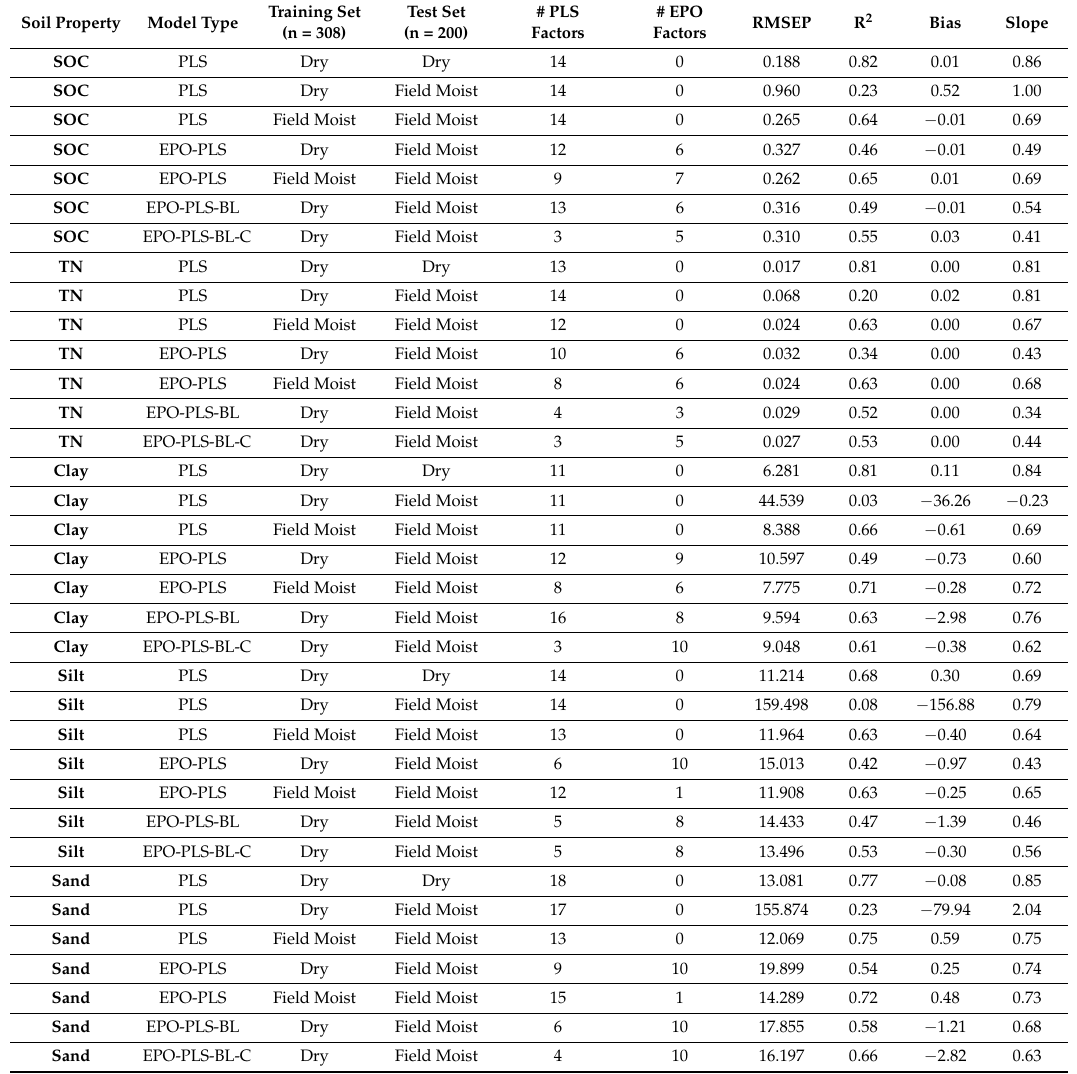
Table 3. The root mean square error of prediction (RMSEP) for the best model within each model type including partial least squares (PLS), external parameter orthogonalization (EPO) transformation, Bayesian Lasso (BL), and covariate addition (C) for each soil property: soil organic carbon (SOC), total nitrogen (TN), and particle size fractions in % (g × 100 g − 1 soil). The EPO transformation was determined on an independent set of field moist and dry spectra (n = 200), and the number of EPO factors is shown. The number of PLS factors corresponds to the number chosen by the PLS package in PLS and PLS-EPO models, and refers to the number kept in the prefilter step for Bayesian Lasso models. R 2 , bias, and slope represent the best-fit line between the actual and predicted values for each soil property and model